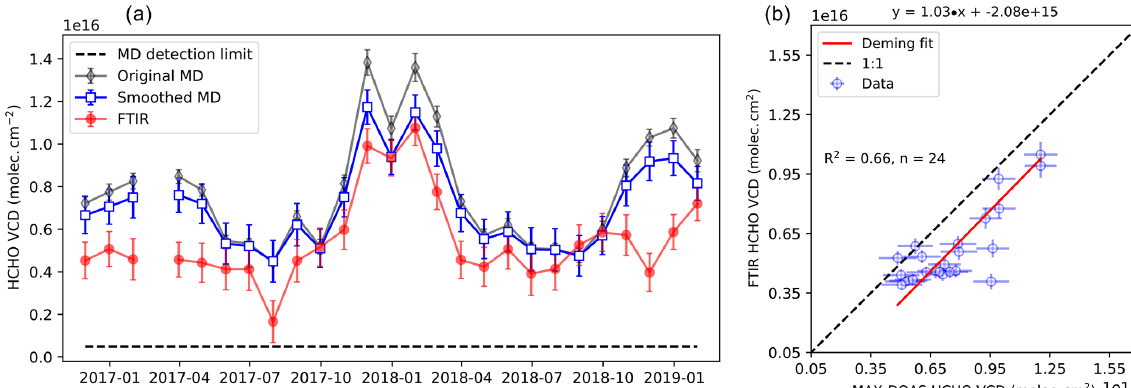
Figure 6. (a) Time series comparison of monthly averaged FTIR and MAX-DOAS (original and smoothed with FTIR averaging kernels) HCHO vertical columns from November 2016 to January 2019 at Lauder. (b) Scatter plot comparison of FTIR with MAX-DOAS smoothed HCHO